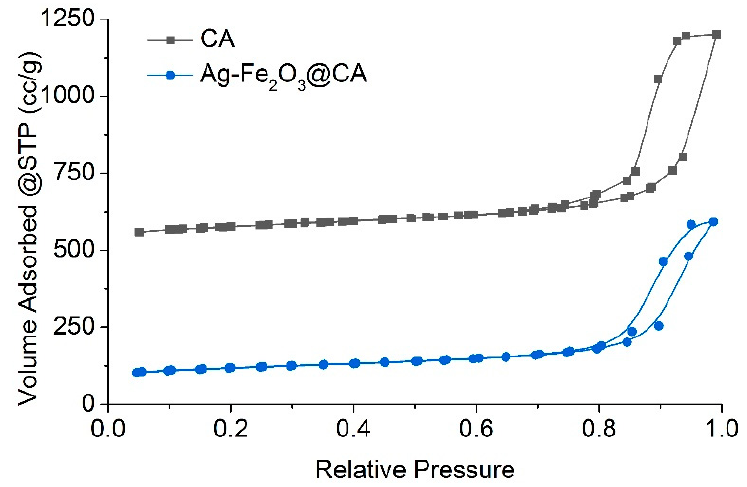
Figure 7. The N 2 adsorption and desorption isotherms.